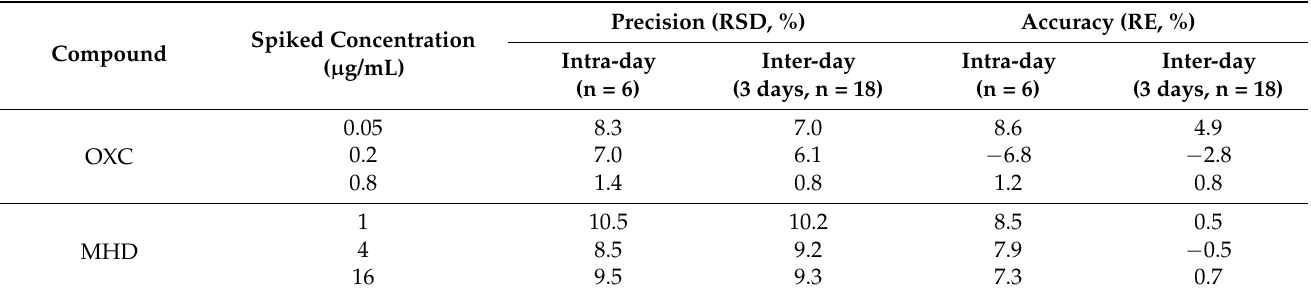
Table 1. Precision and accuracy of oxcarbazepine (OXC) and 10-hydroxycarbazepine (MHD) from LC-triple-stage fragmentation (MS 3 ) method.